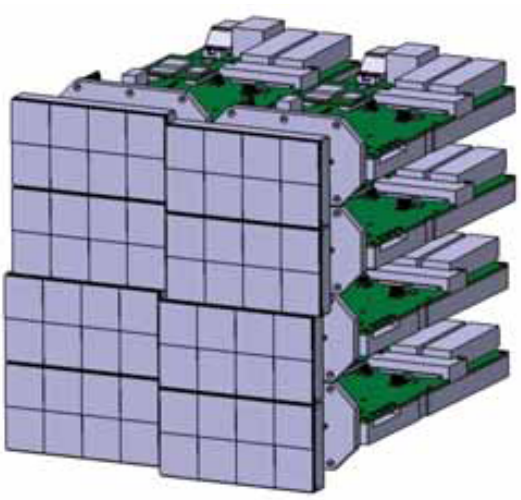
Figure 19. Mechanical drawing of a 4M JUNGFRAU detector, showing a possible module arrangement around a small central